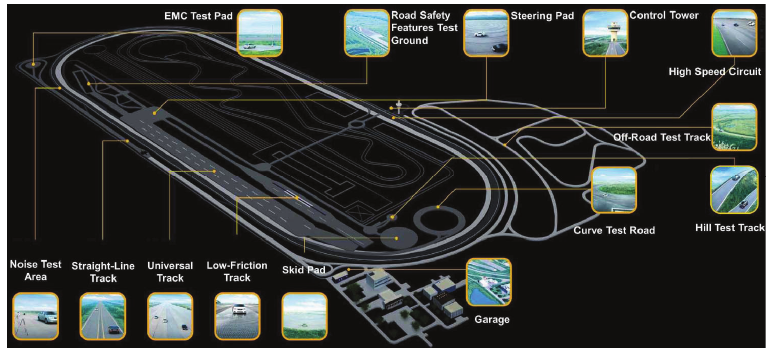
Figure 5. Test road: Korea Automobile Testing & Research Institute